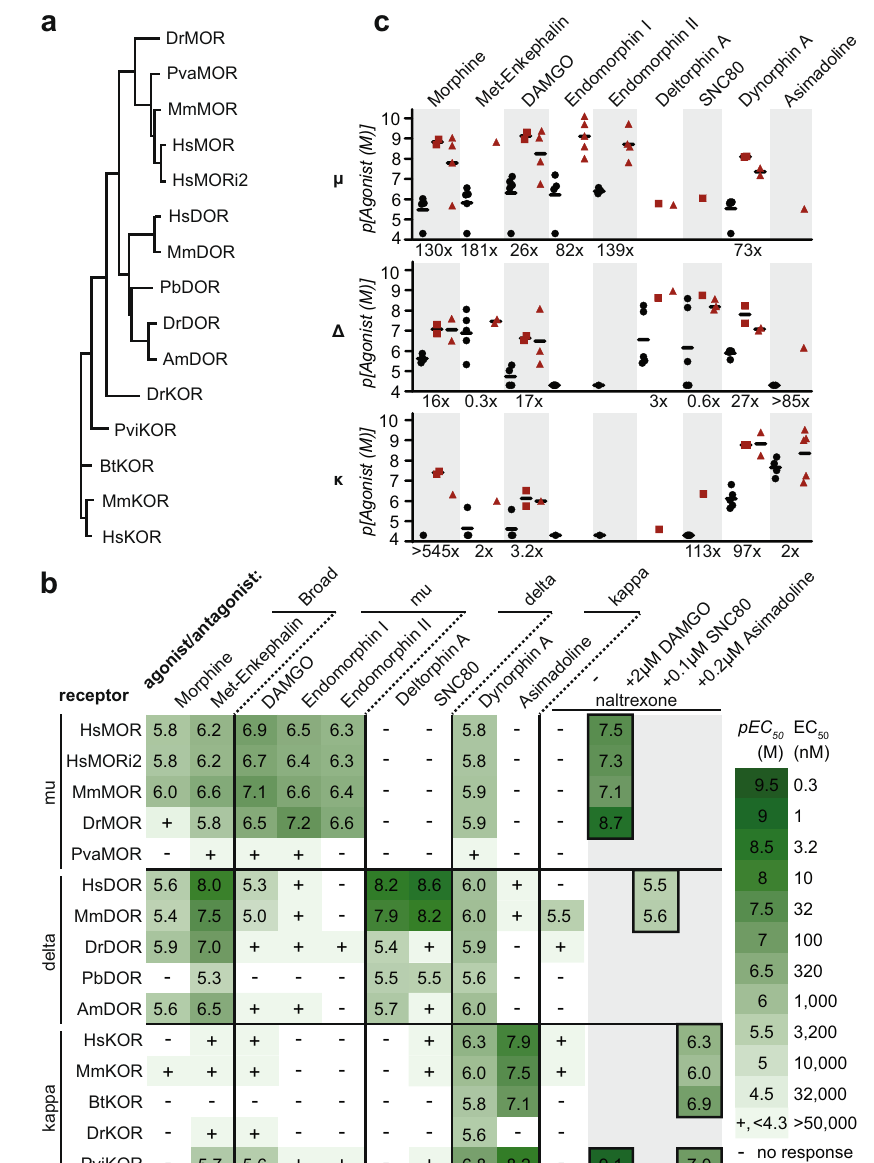
Fig. 2 Activity of opioid receptors in the cholesterol-producing strain. a A protein-based phylogenetic tree of opioid receptors selected to make biosensors. MOR, mu receptor, KOR, kappa receptor, DOR, delta receptor. Dr, D. rerio , zebra fi sh; Pva, P. vampyrus , fl ying fox; Mm, M. musculus , mouse; Pb, P. bivittatus , python; Am, A. mexicanus , Mexican tetra; Pvi, P. vitticeps , bearded dragon; Bt, B. taurus , cow. i2, isoform 2. b Activities of agonists and the antagonist naltrexone on opioid receptors were assayed by fl ow cytometry and mean pEC 50 was determined. Agonists clustered by literature receptor-type speci fi city. n = 3 biologically independent experiments, >2073 cells/condition/replicate. c Biosensor agonist sensitivities (EC 50 , black circles) relative to sensitivities reported in the literature for mammalian receptors as inhibition constants (Ki, red squares) and EC 50 /IC 50 values (red triangles) 34 – 45 . Fold decrease in sensitivity of the best biosensor relative to the literature average is indicated. Source data are provided as a Source Data fi